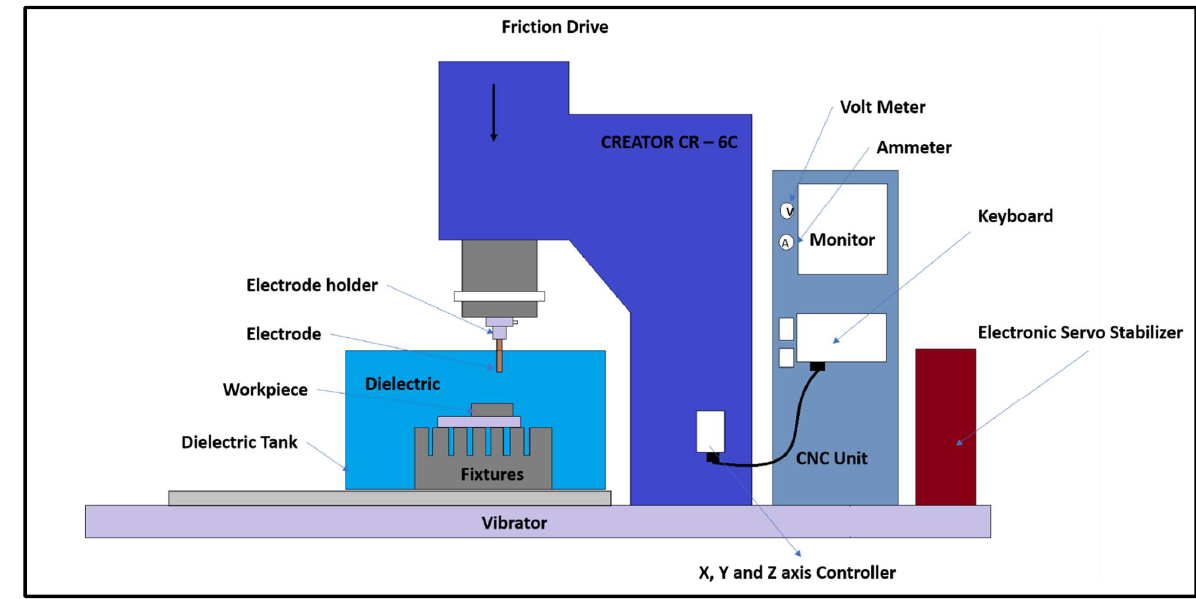
Table 1. Ti-6Al-4V Chemical composition.